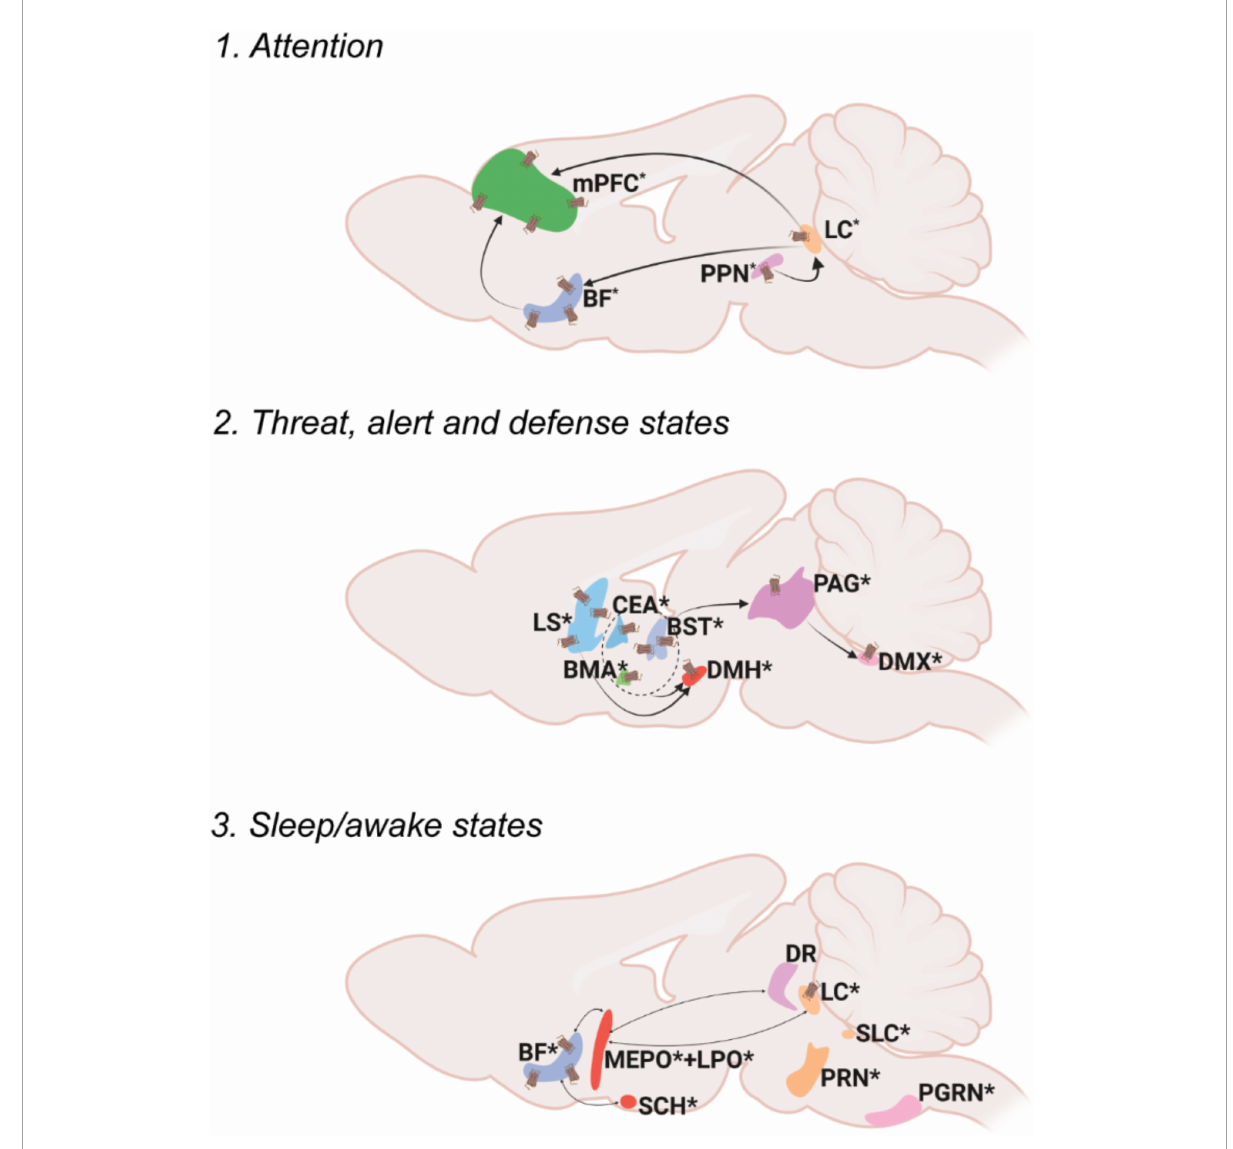
FIGURE1 Oxt associated circuitry in internal state control. Pathways depicting three different functional circuits: 1. Attention, 2. Threat, alert and defense states, 3. Sleep/awake states. * denotes the presence of Oxt projection fiber in the specified area. Receptor symbol depicts presence of OxtR on the area mentioned. For abbreviations, refer Table 1